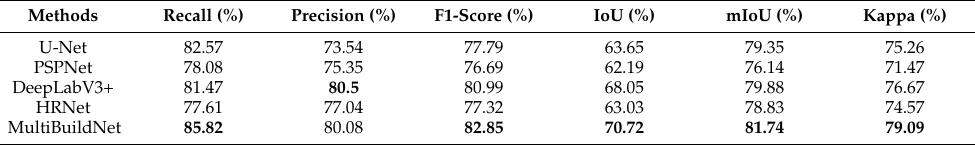
Table 7. Accuracy of building footprint segmentation on the Massachusetts